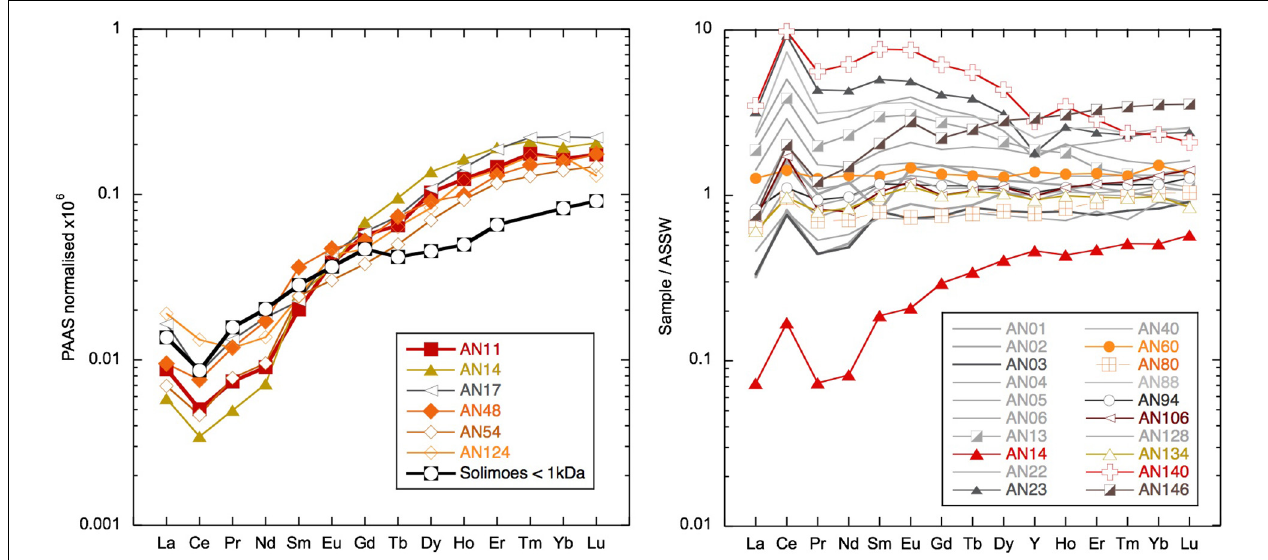
FIGURE 11 | Left: low rare earth element (REE) concentration samples compared with < 1 kDa truly dissolved fraction from the Amazon tributary Solimões (Merschel et al., 2017b). Right: selected samples normalized to Andaman Sea Surface Water (ASSW) (PA10 < 0.04 µ m of dissolved phase from Nozaki and Alibo, 2003).